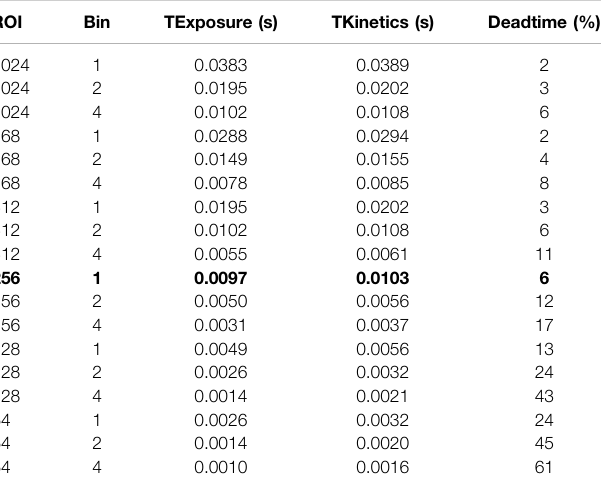
TABLE 5 | Min. Exposure/kinetic cycle time